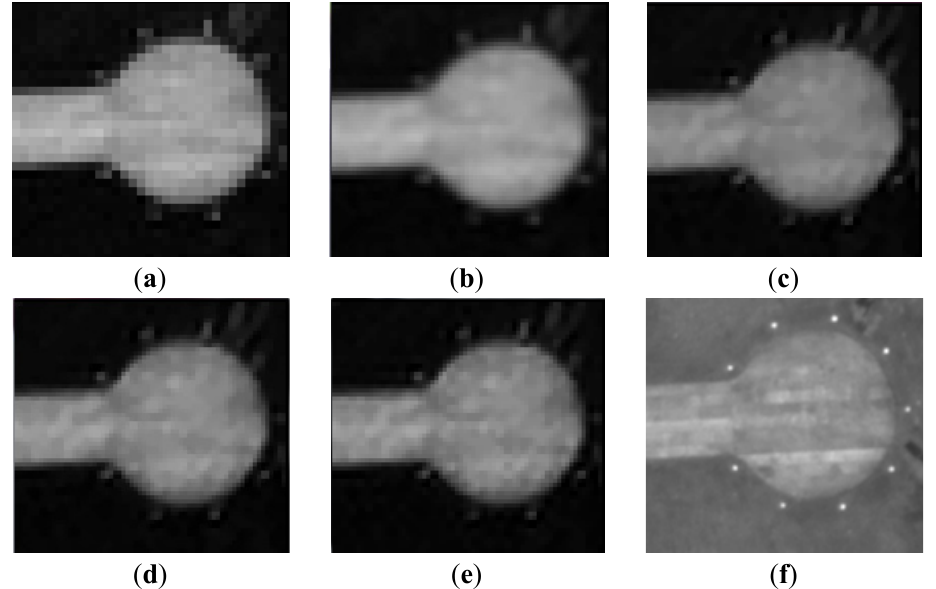
Figure 11. Local amplification 1 of the real experiment result shown in Figure 9. ( a ) LR reference image; ( b ) bilinear interpolation; ( c ) GEN; ( d ) ANGW; ( e ) RESW; ( f ) panchromatic image.